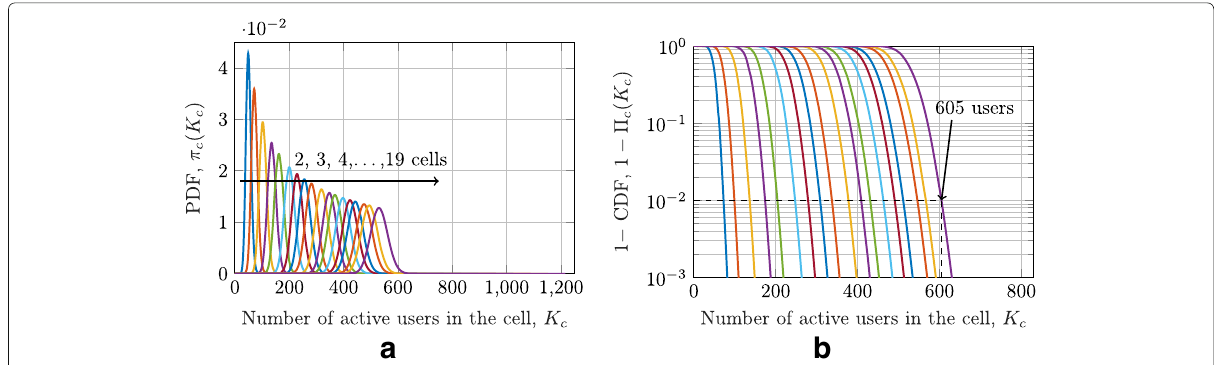
Fig. 6 Statistical multiplexing. Exemplary distribution of served users/required user streams for 19 aggregated RRUs. ¯ (cid:8) = 45 Gbps / km 2 , = 10 m. a PDF and b σ (cid:8) = 0.25 ¯ (cid:8) , d corr